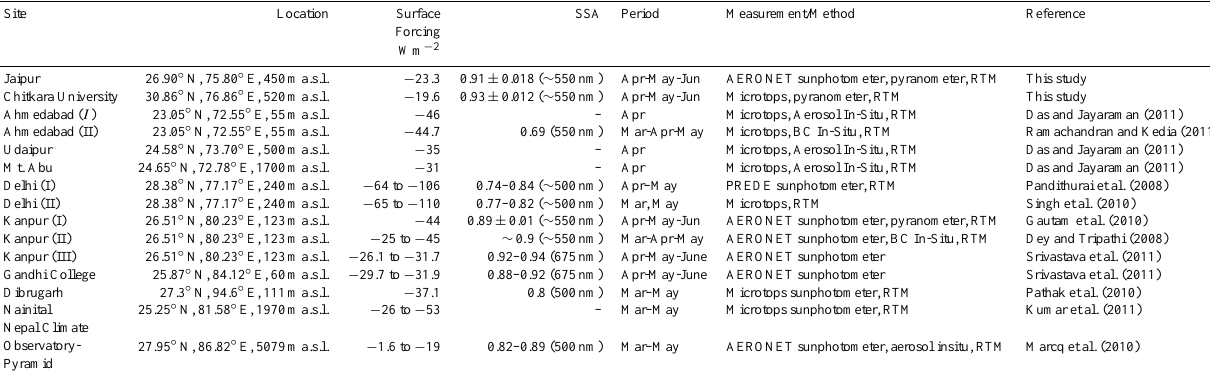
Table 4. Aerosol radiative forcing estimates over Northern India and Nepal (north of 20 ◦ N) during pre-monsoon season from this study and published